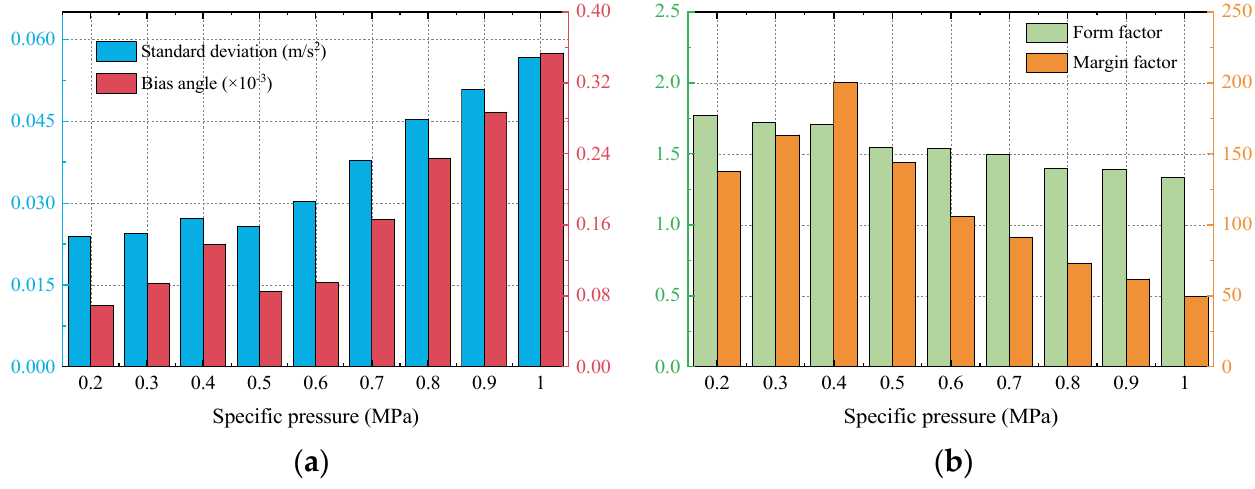
Figure 16. Effect of the specific pressure on the time domain eigenvalues. ( a ) Standard deviation and bias angle, ( b ) form factor and margin factor.